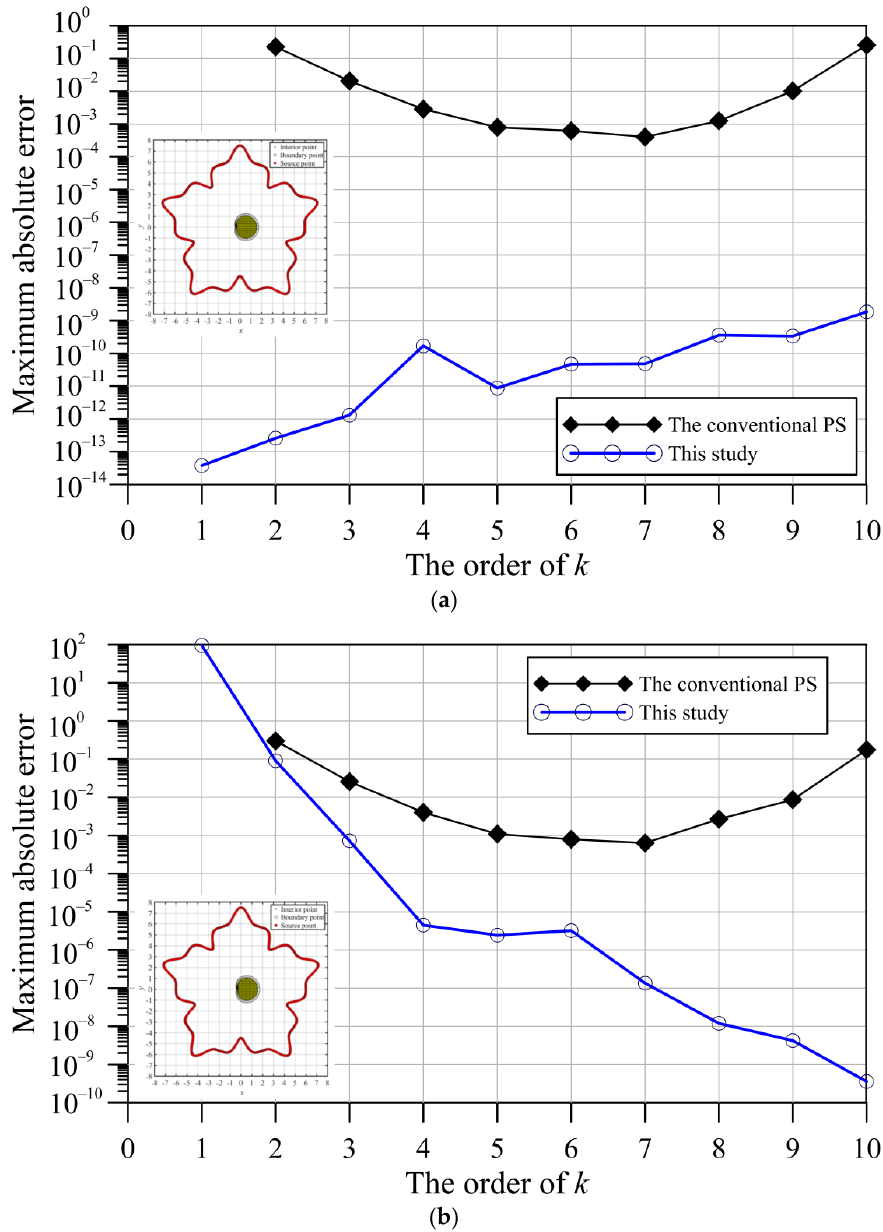
Figure 7. The computed MAE values of the original PRBF and the proposed method: ( a ) λ 2 = 0.0001; ( b ) λ 2 =